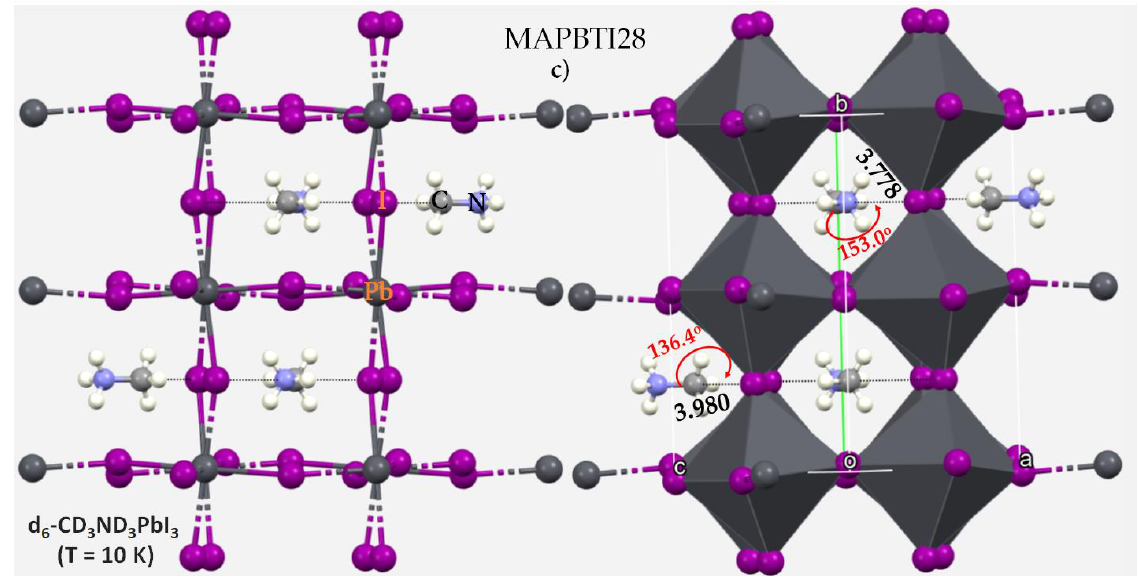
Figure 3. Ball-and-stick ( left ) and polyhedral ( right ) models of the low-temperature or- thorhombic phase of organic-inorganic hybrid lead halide perovskites: ( a ) o-CH 3 ND 3 PbCl 3 [86], ( b ) o-CH 3 ND 3 PbBr 3 [87] and ( c ) o-CD 3 ND 3 PbI 3 [88]. The bond distances, r (N ··· X) in Å, and bond angles, ∠ R–N/C ··· X (R = C, N) in degrees, associated with the N ··· X and C ··· X (X = Cl, Br, I) pnictogen bonding and tetrel bonding interactions between the organic and inorganic frameworks are shown in each case. Dotted lines between atoms represent non-covalent interactions. Atom labeling is shown in each case, and H/D atoms are tiny spheres in white-gray. The N-H/N-D ··· X and C-H/N-D ··· X hydrogen bonds/deuterium bonds are not shown, and the CSD references are shown in capital